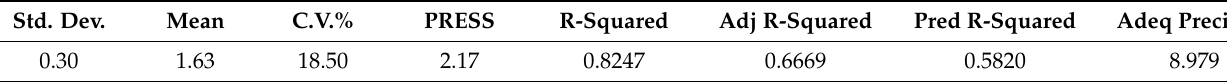
Table 5. Results of variance analysis of R